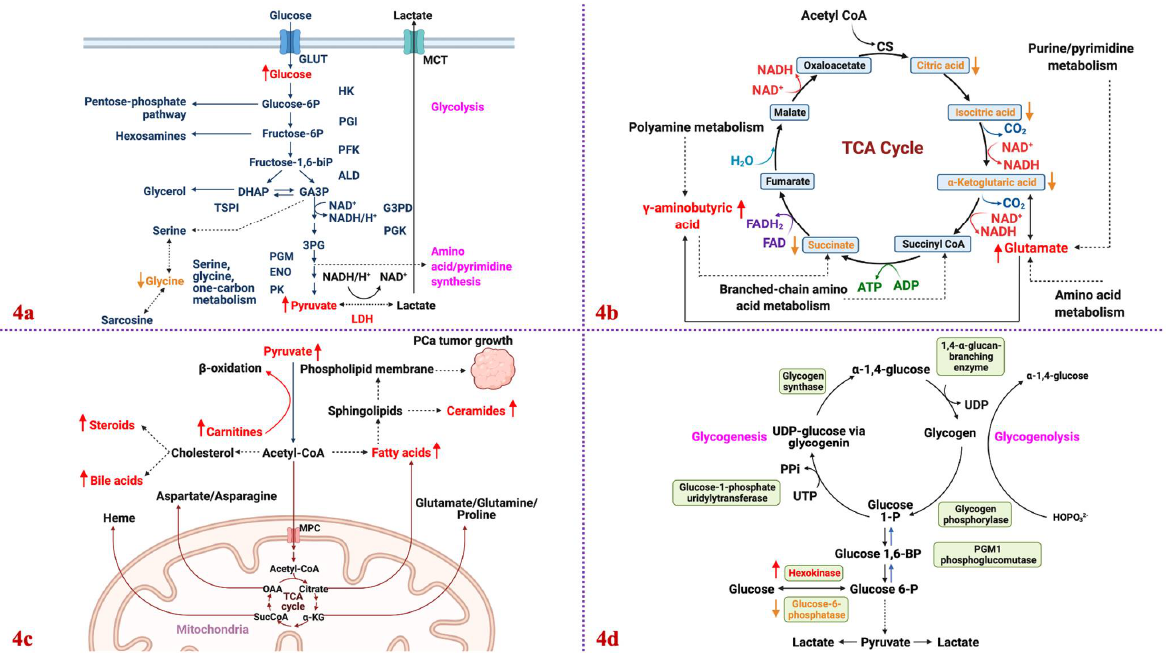
Figure 4. Schematic overview of the four canonical pathways dysregulated in human PCa tumorigenesis. Biofluid samples are extracted and analyzed to reflect changes in metabolites and enzymes for PCa biomarker discovery: Glycolysis ( a ), TCA cycle ( b ), de novo lipogenesis ( c ), and glycogenesis/glycogenolysis ( d ). Red font = increased metabolites/upregulated enzymes; Orange = decreased metabolites/downregulated enzymes. MCT = monocarboxylate transporter; HK = hexokinase; PGI = phosphoglucose isomerase; PFK = phosphofructokinase; ALD = aldolase; DHAP = dihydroxyacetone phosphate; GA3P = gyceraldehyde-3-phosphate; GA3PD = gyceraldehyde-3-phosphate dehydrogenase; PGK = phosphoglycerate kinase; 3PG = 3-phosphoglycerate; PGM = phosphoglyceromutase; ENO = enolase; PK = pyruvate kinase; LDH = lactate dehydrogenase; CS = citrate synthase; OAA = oxaloacetate; UDP = uridine diphosphate; UTP = uridine triphosphate. Figure drawn using BioRender